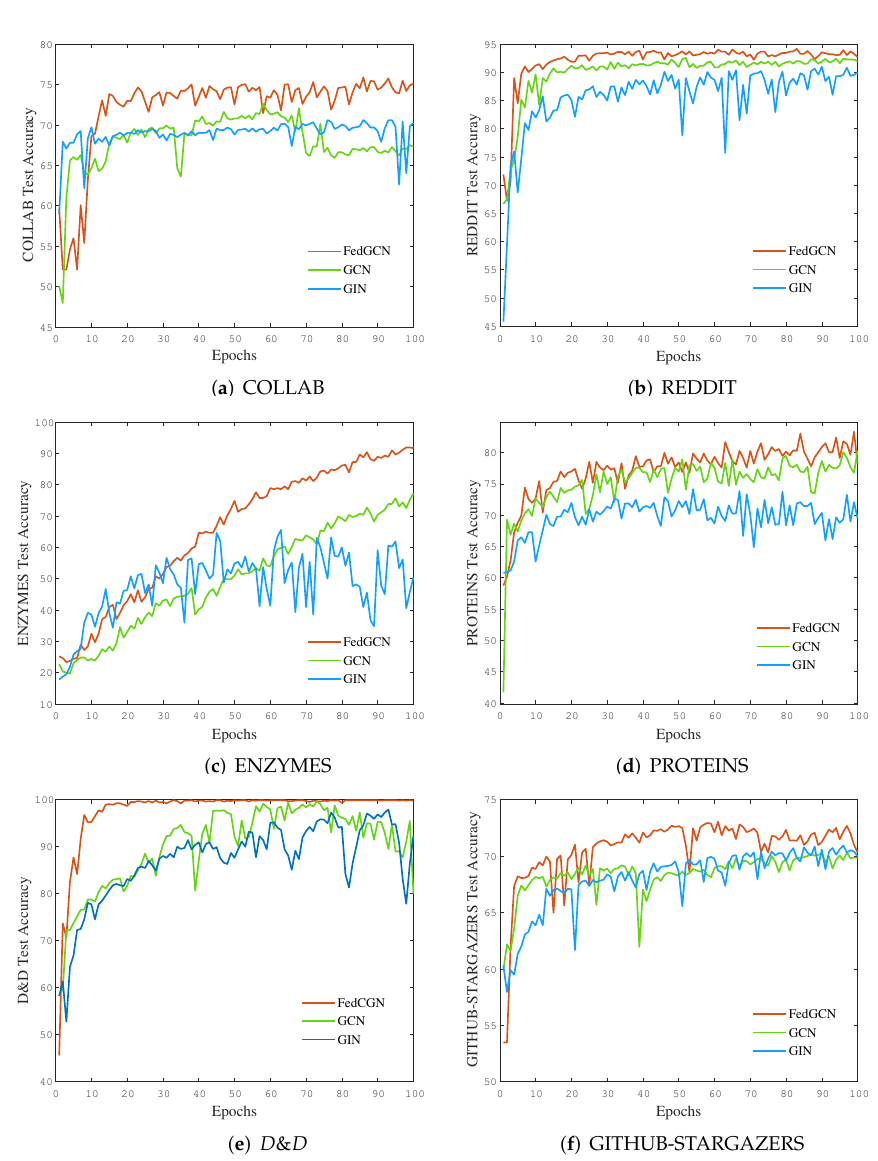
Figure 8. Accuracy experiment of FedGCN algorithm on six